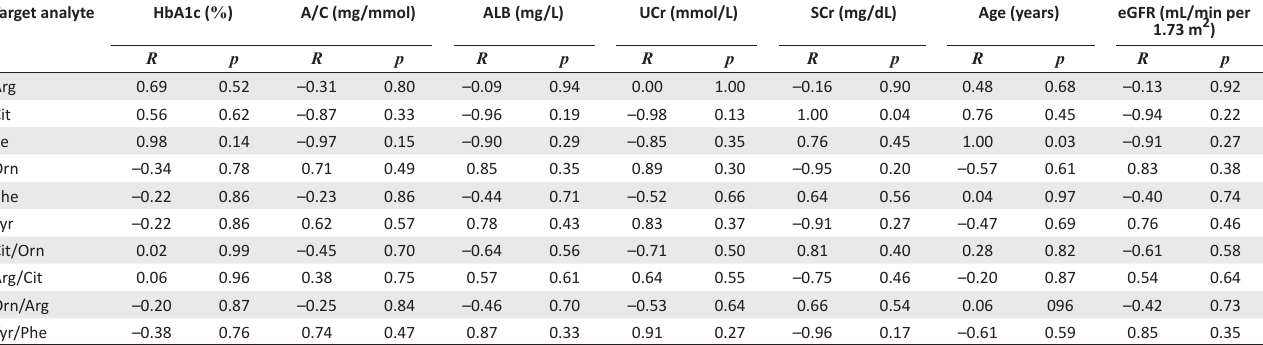
TABLE 3 : Correlation between the amino acid concentrations and ratios and clinical data of non-diabetic patients, Johannesburg, South Africa, November 2019 to January 2021. Target